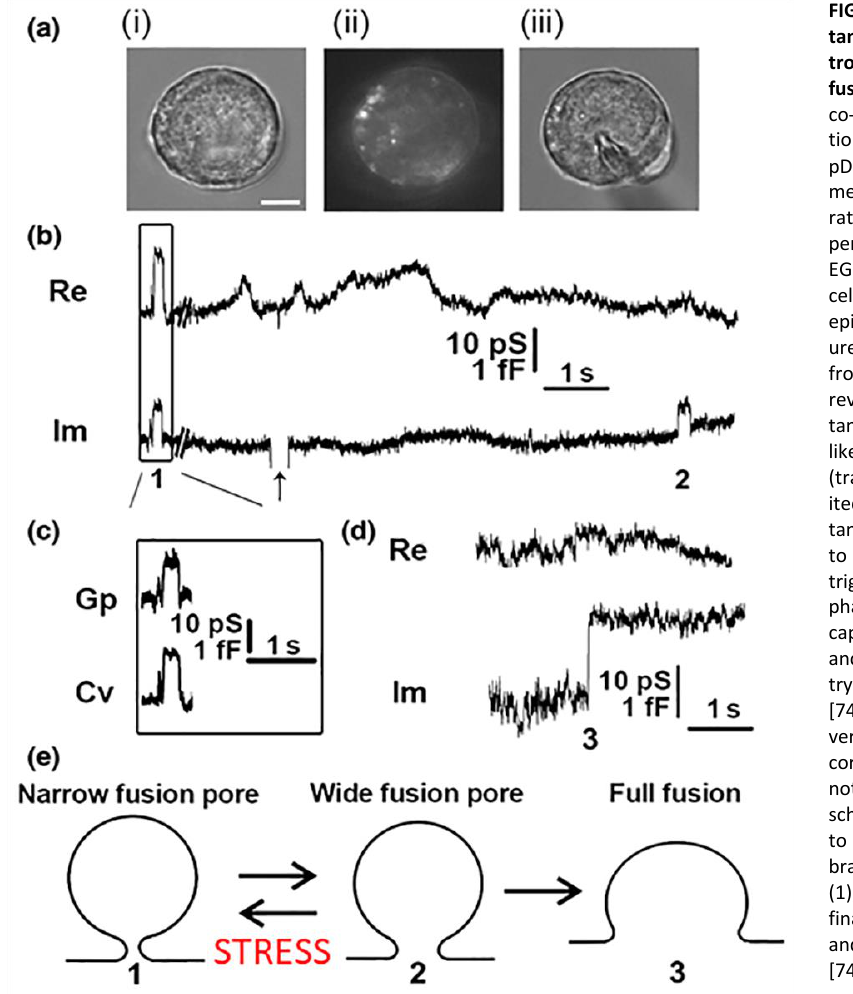
FIGURE 3: Cell ‐attached membrane capaci‐ tance (C m ) measurements on pituitary lacto- trophs show transient (reversible) and full fusion exocytotic events. (A) Lactotrophs co-transfected with hyperpolariza- tion-activated and cyclic nucleotide-gated